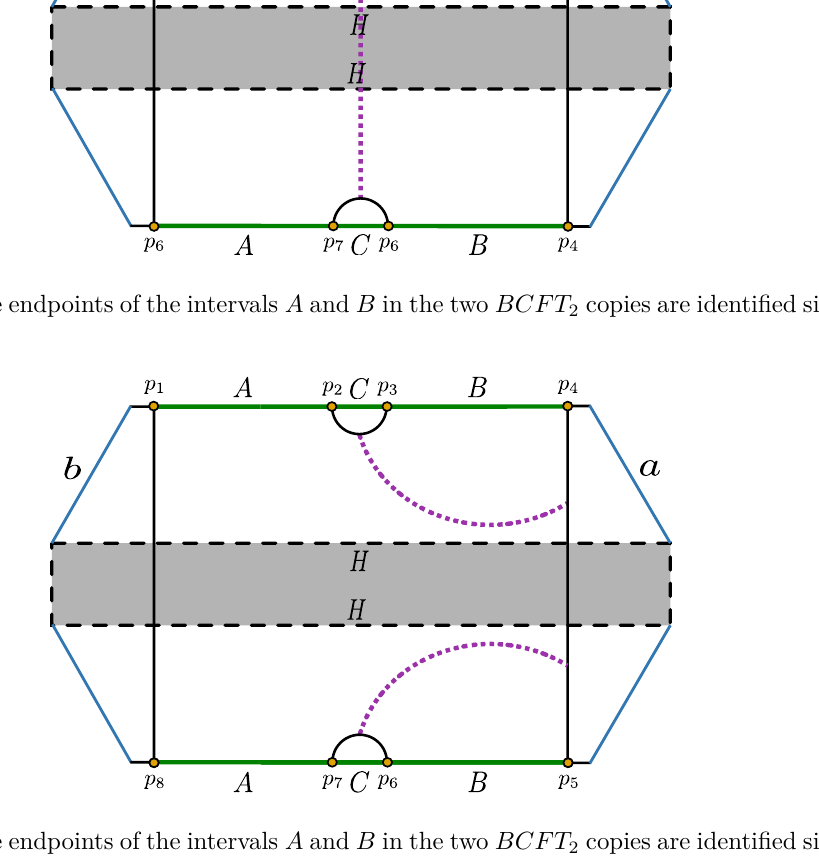
Figure 32 . The endpoints of the intervals A and B in the two BCFT 2 copies are identified similarly as in figure